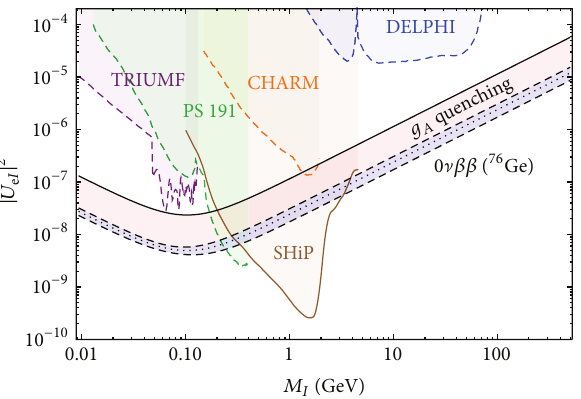
Figure 13: Schematic view of the 2 ] 𝛽𝛽 and the 0 ] 𝛽𝛽